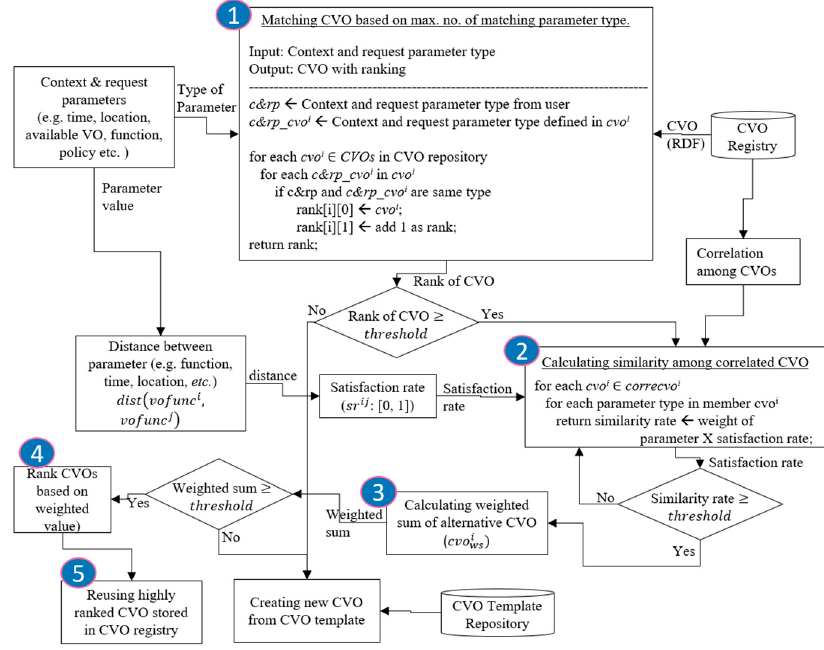
Figure 6. Flowchart of an algorithm for reusing CVOs.